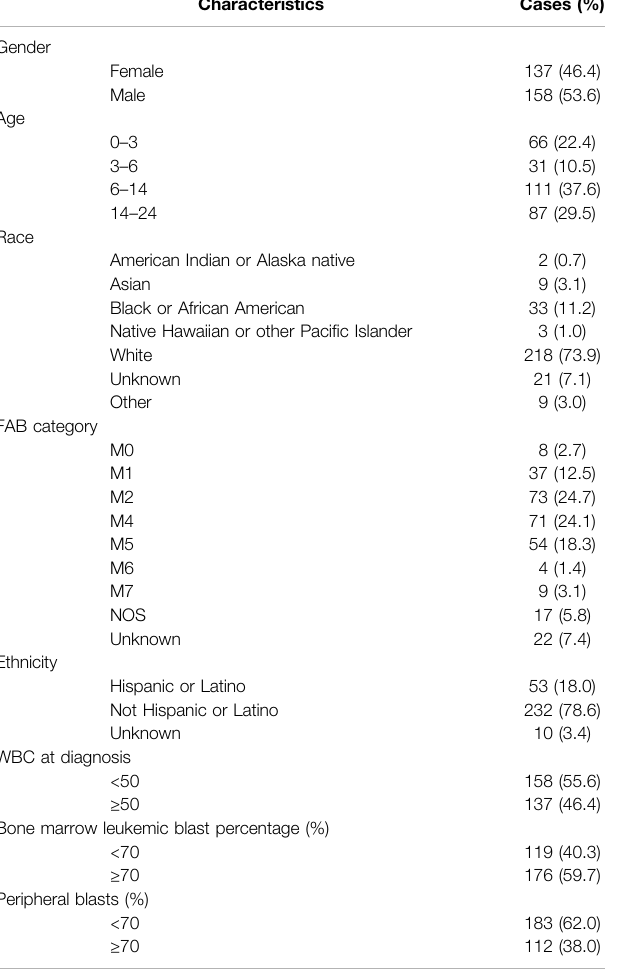
divided the samples into three subgroups based on the maximum